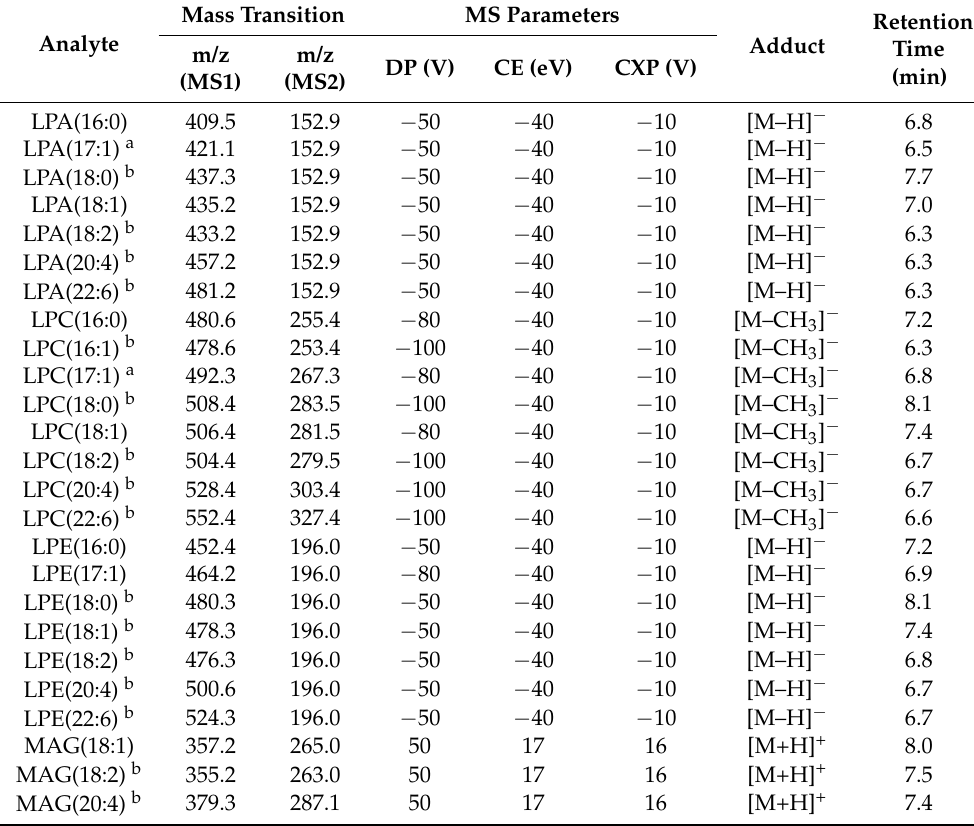
Table 4. MS parameters for studied